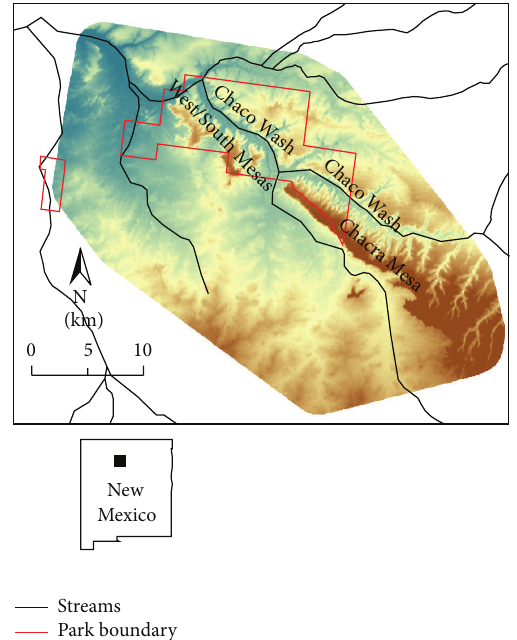
Figure 1: Location and topographic relief of Cervus elaphus use area in northwestern New Mexico, USA. Location of Chaco Culture National Historical Park is